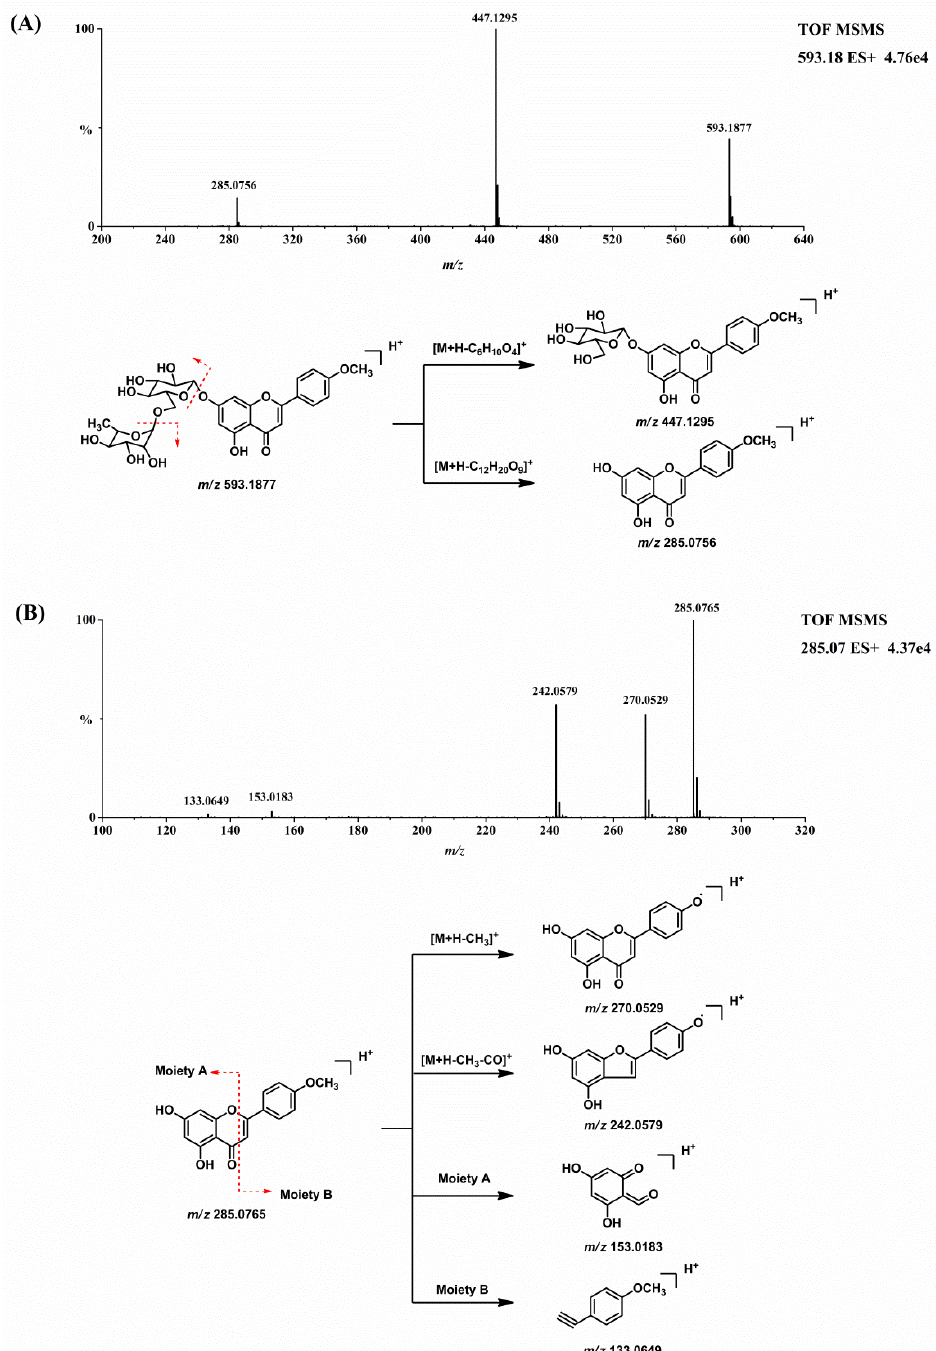
Figure 3. MS/MS product ion spectrum and the proposed fragmentation pathways of linarin ( A ) and acacetin ( B ). acacetin ( B